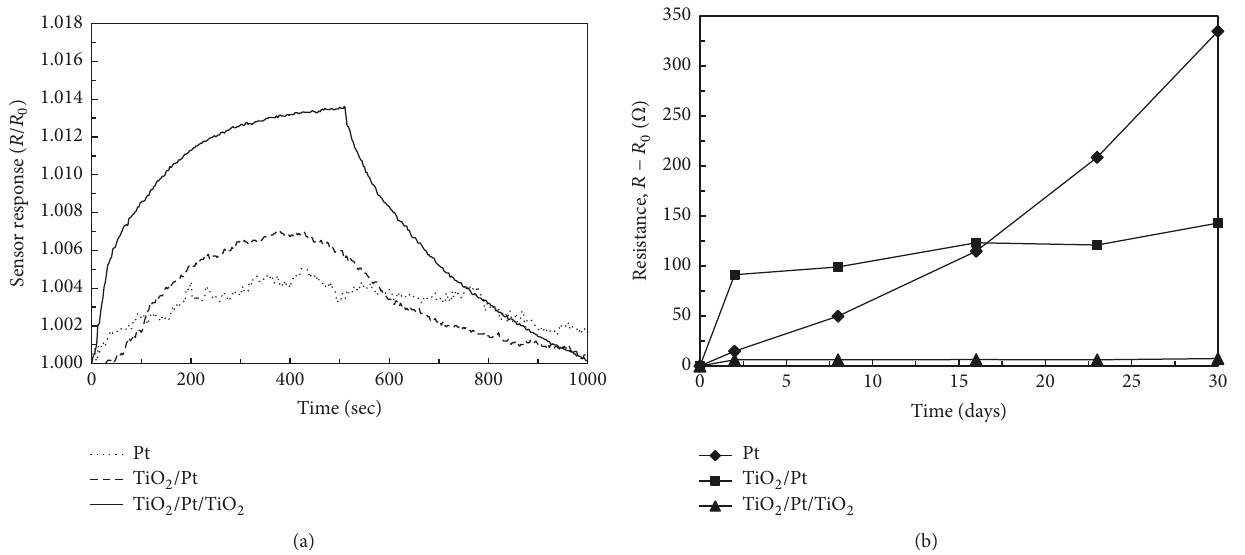
Figure 4: (a) Sensor responses of Pt, TiO 2 /Pt, and TiO 2 /Pt/TiO 2 to 100ppm ethanol vapor and (b) resistance change of each sensor upon 100ppm ethanol exposure.